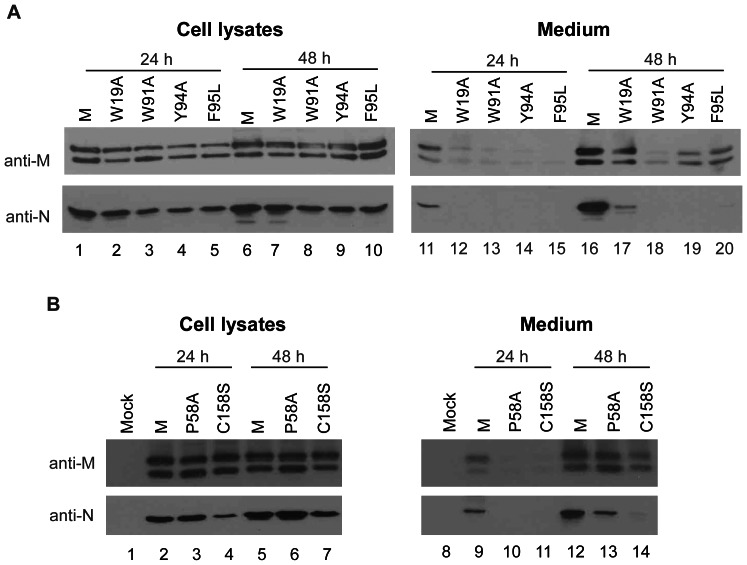
VLP accumulation in medium.293T cells were cotransfected with SARS-CoV N and wt or indicated mutant M expression vector. Equal amounts of cells were placed on two dish plates 4 h post-transfection. Supernatant and cells were harvested at 24 h and 48 h post-transfection, prepared, and subjected to Western immunoblotting.